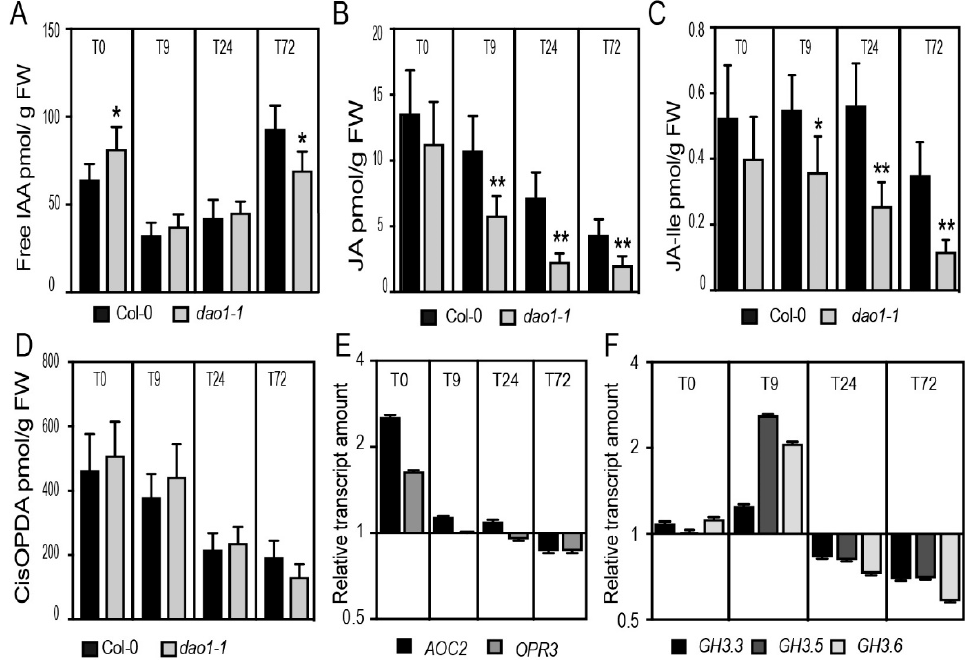
Figure 4. The AR phenotype of the dao1-1 mutant is probably linked to its deficiency in JA and JA-Ile. ( A – D ) Endogenous hormone contents. ( A ) Free IAA, ( B ) free JA, ( C ) JA-Ile, and ( D ) cis -OPDA were quantified in the hypocotyls of wild-type and dao1-1 mutant seedlings grown in the dark until the hypocotyl reached 6 mm long (T0) and after their transfer to the light for 9 h (T9), 24 h (T24) and 72 h (T72). Asterisks indicate a statistically significant difference in the mutant lines versus the wild type in an ANOVA analysis (* and **correspond to p -values of 0.05 > p > 0.01, 0.01 > p > 0.001). Error bars indicate ± SD of six biological replicates. ( E ) Relative transcript amount of two key genes in the JA biosynthesis, AOC2 and OPR3 , as well as ( F ) GH3.3 , GH3.5 , and GH3.6 quantified by qRT-PCR. mRNA was extracted from hypocotyls of wild-type and dao1-1 mutant seedlings grown in AR phenotyping conditions as indicated above. The gene expression values are relative to the wild type, for which the value was set to 1. The scale in the Y axis is indicated as a log2 unit Error bars indicate ± SEM obtained from three technical replicates.